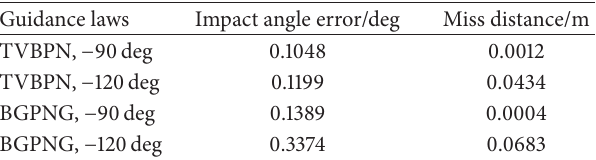
Table 1: Simulation results between two guidance laws. Guidance